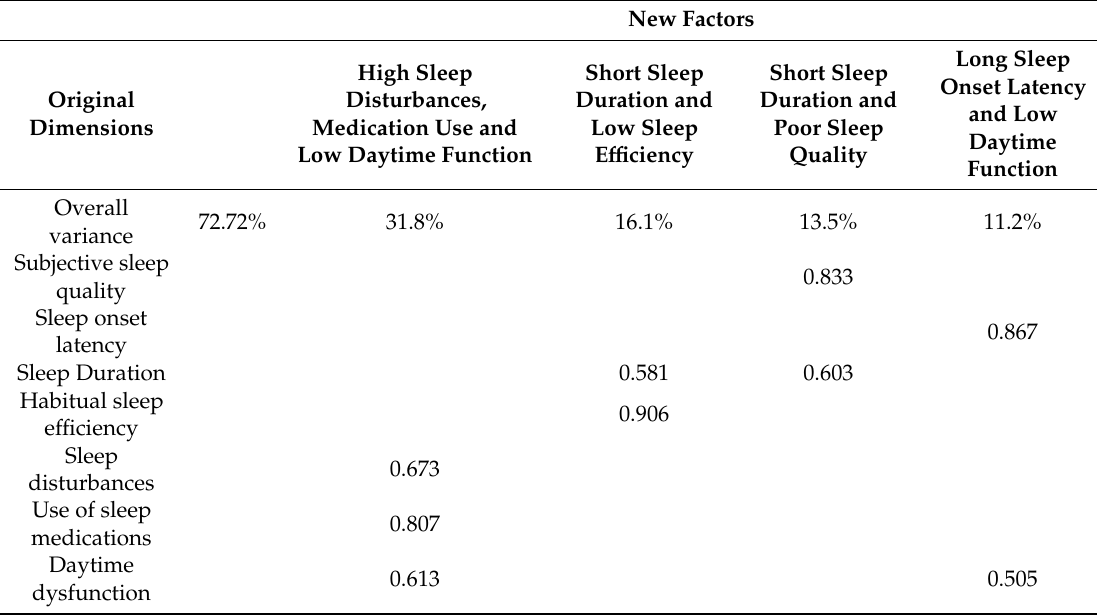
Table 5. Factor analysis: Four-factor solution of the seven dimensions of the Pittsburgh Sleep Quality Index (PSQI); correlation coe ffi